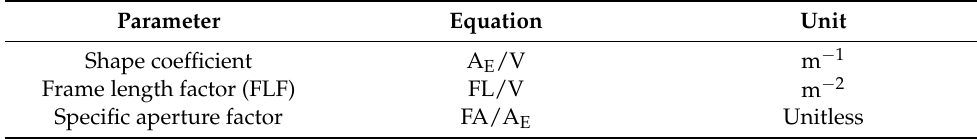
Table 3. Derived building parameters used in the statistical analysis of results.